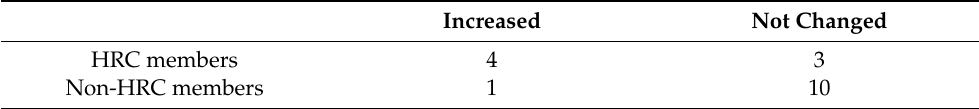
Table 11. Opinion on interaction with the outside community. Increased Not Changed